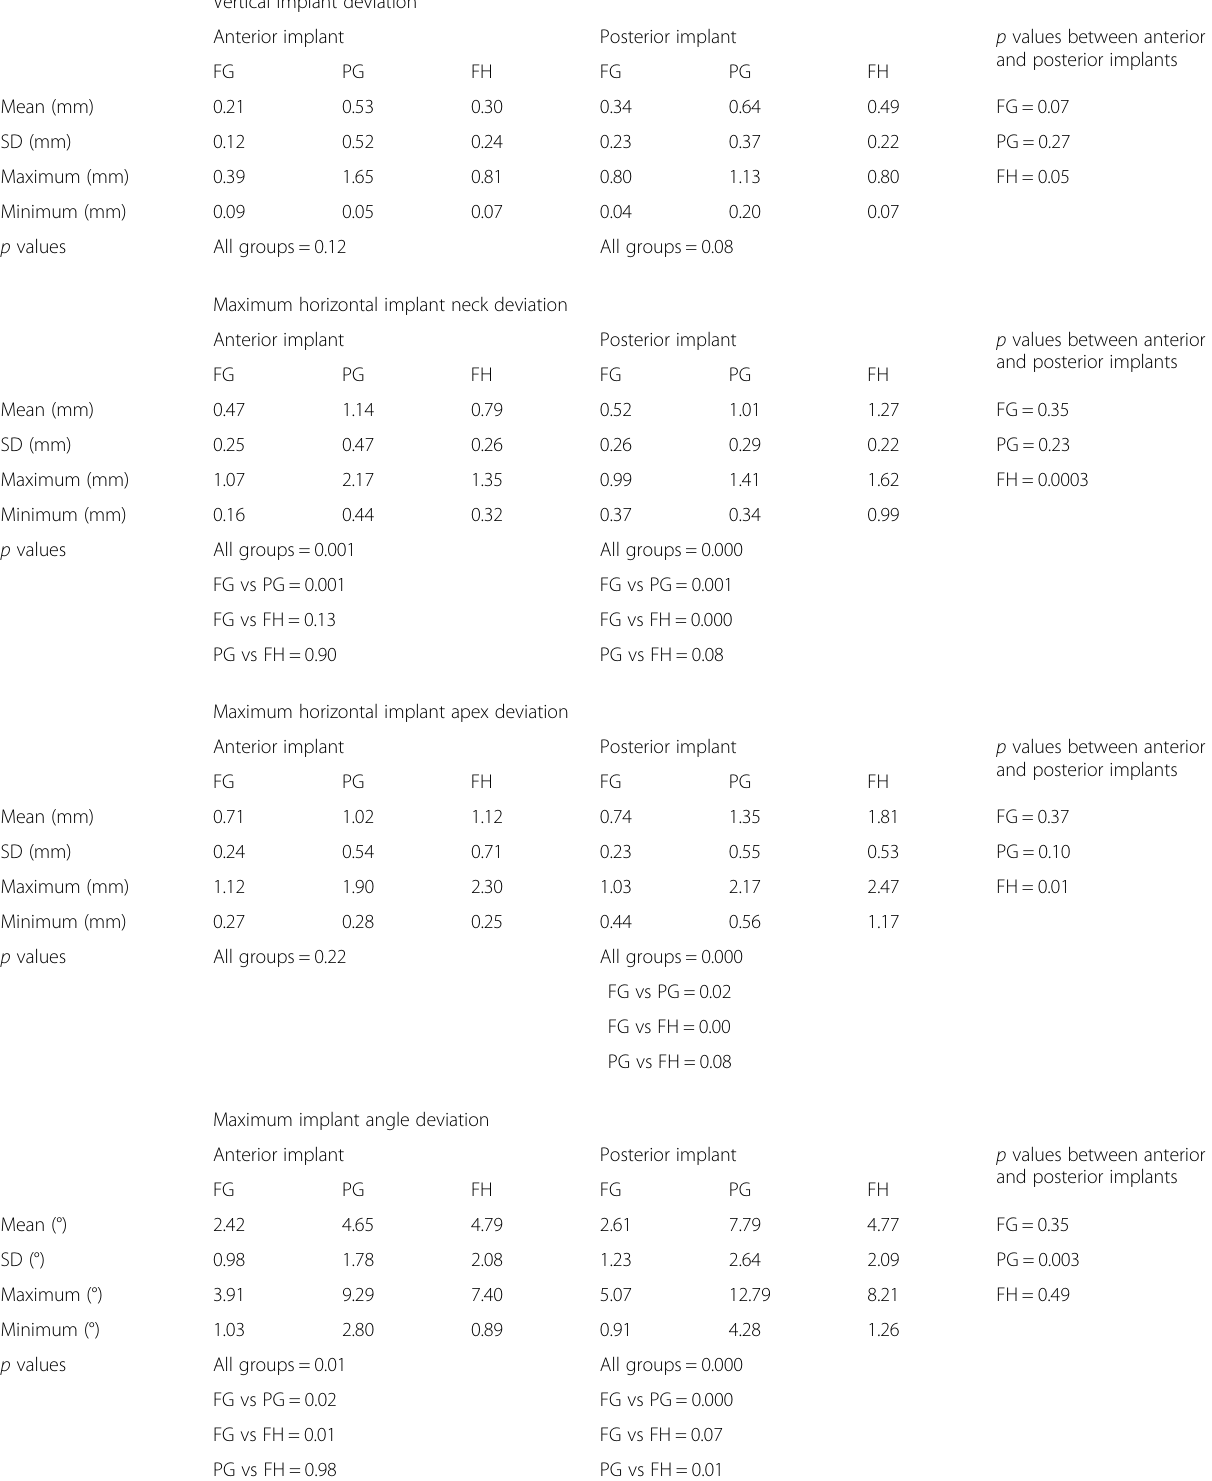
Table 1 Summary of implant vertical, horizontal and angle deviations from the planned implant Vertical implant